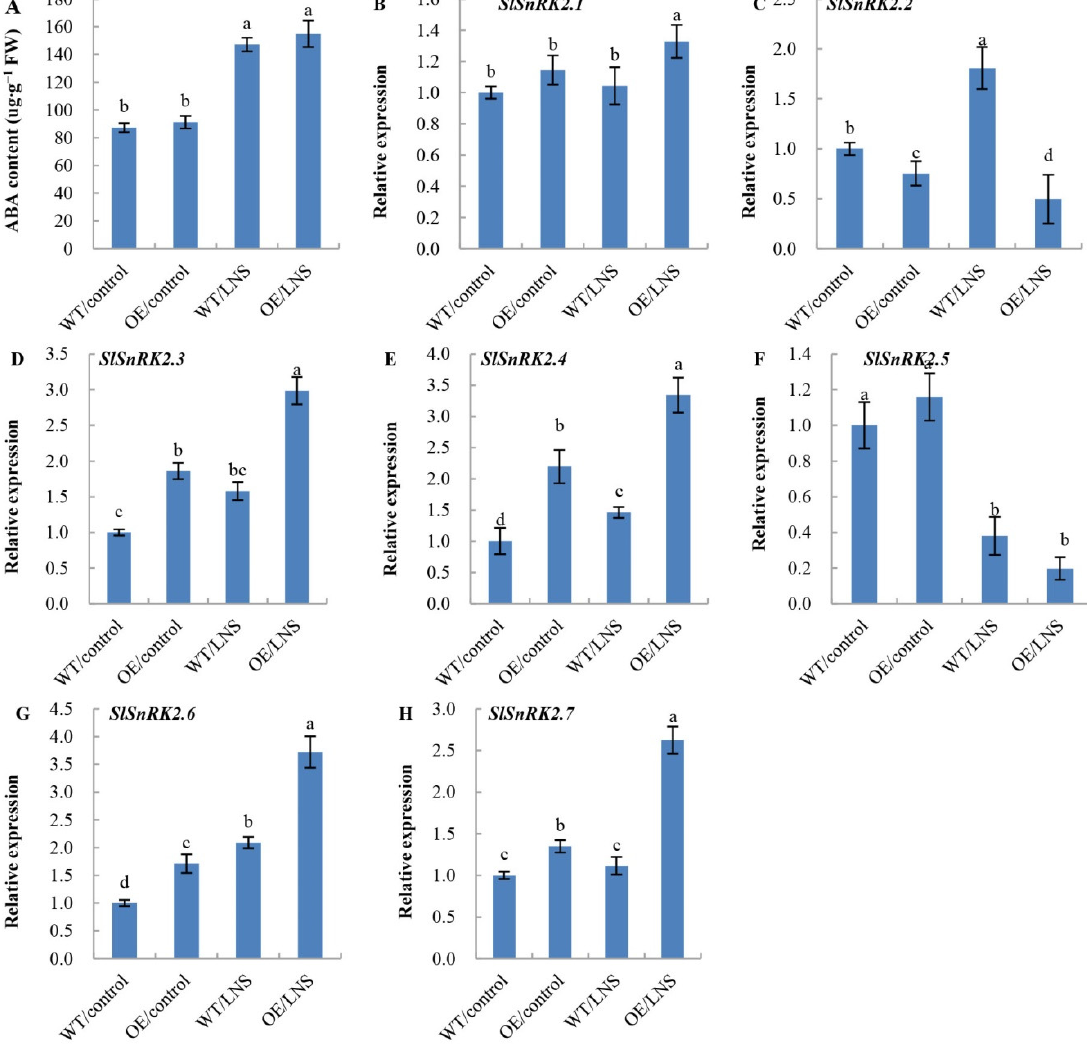
Figure 5. Effects of PpSnRK1 α overexpression on ABA content ( A ) and the transcription level of SlSnRK2s ( B – H ). Data are expressed as the mean ± SD of biological triplicates. Different lowercase letters indicate significant differences according to Duncan’s multiple range test ( p < 0.05).